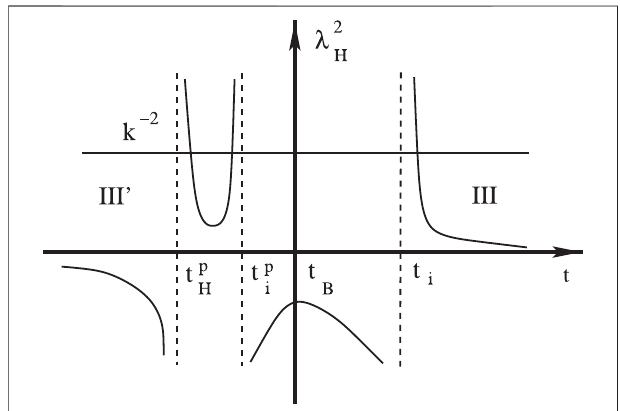
FIGURE9| Schematicplotof λ 2 H de fi nedby Eq.4.10 fortheStarobinsky potential and mLQC-I in the hybrid approach, where s ( t i ) (cid:2) s ( t p i ) (cid:2) s ( t p H ) (cid:2) 0, and t (cid:2) t i is the starting time of the in fl ationary phase. During the slow-roll in fl ation, we have λ 2 H ≈ L 2 H / 2 (Region III). In the contracting phase, the background is asymptotically de Sitter. The evolution of the universe is asymmetric with respect to the bounce. In particular, λ 2 H is strictly negative for t p i < t < t i , while for t ≃ t p − i it becomes positive and large. However, as t decreases, λ 2 H becomes negative again. The qualitative behavior of λ 2 H does notchangewiththechoiceoftheinitialconditionsaslongasthein fl atoninitially starts from the left wing of the potential at the kinetic-energy-dominated bounce. However, the exact values of t i and t H depend on the initial conditions. For example, when ϕ B (cid:2) − 1 . 32 m pl , t p H (cid:2) − 7 . 88 t pl , t p i (cid:2) − 4 . 11 t pl and t i (cid:2) 4 . 90 × 10 5 t pl